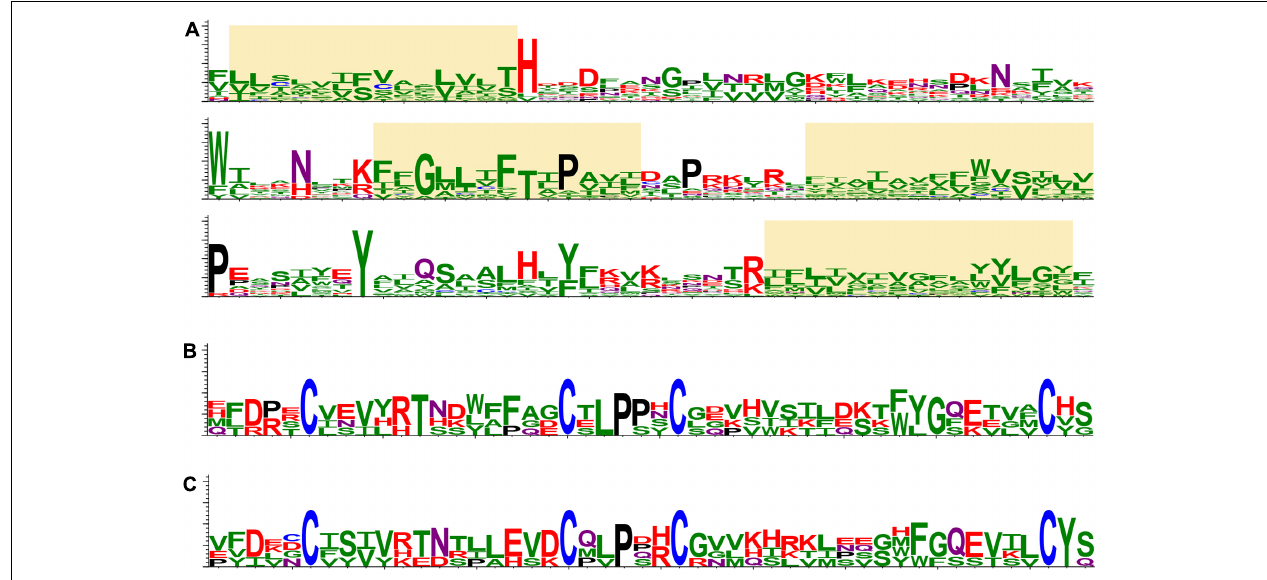
FIGURE 2 | Protein structure conservation depicted as sequence logos based on aligned protein sequences. (A) The most conserved region of SP24 proteins in plant and insect viruses. Yellow boxes indicate stretches of hydrophobic amino acid residues. The logo is based on the following sequences: Loreto virus (accession number KX518775); Anopheline-associated C virus (KF298279); Blueberry necrotic ring blotch virus (JN651150); Chronic bee paralysis virus (ANG65715); Hibiscus green spot virus (HQ852054); Ambrosia trifida (GEOH01007094); Triticum polonicum (GEDQ01066052); Camellia sinensis (GFMV01045386 and GARM01000026); Paulownia tomentosa (GEFV01018861); Panax ginseng (GDQW01045297); Elaeocarpus photiniifolius (FX134396); Gevuina avellana (GEAC01035000); Citrus leprosis virus C (NC008170); Humulus lupulus (GAAW01021049). (B) CBPV ORF2-like proteins in insect viruses. The logo is based on the following sequences: Chronic bee paralysis virus , Loreto virus , Negev virus , Piura virus, and Wuhan house centipede virus 1 . (C) CBPV ORF2-like proteins in virus-like RNA in plant transcriptomes. The logo is based on the following sequences: Triticum polonicum (GEDQ01066052), Panax ginseng (GDQW01045299), Camellia sinensis (GFMV01053147), and Talbotia elegans (SILJ-2021063). The sequence logos visualize the distribution of amino acid residues at each position of conserved motifs. Amino acids are represented in a single-letter code and colored as follows: N and Q, purple; D, E, K, R and H, red; P, black; C, blue; S, T, Y, A, I, L, M, F, V, G and W,